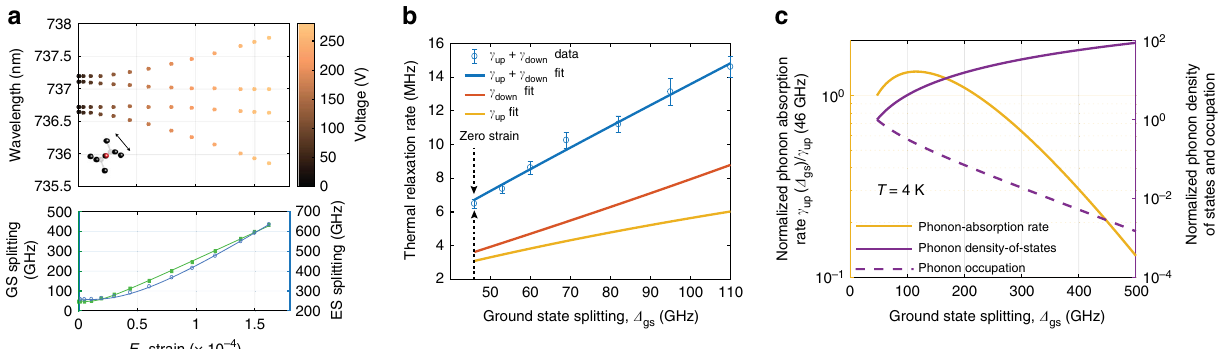
Fig. 2 Strain-tuning of the SiV − energy levels. a Strain response of a transverse-orientation SiV − as shown in Fig. 1c. Wavelengths of the four optical transitions A, B, C, and D are recorded against strain. Raw PLE data with applied voltages can be found in Supplementary Fig. 7. The lower panel shows orbital splittings within GS (solid green squares) and ES (open blue circles) extracted from the optical transition wavelengths. Solid curves are fi ts to group theory-based strain response model. 27, 29 b Thermal relaxation rates between GS orbital branches vs. their energy splitting. Error bars represent standard deviation of the estimated rate, and are under 5% for all data points. Fit to model in Supplementary Discussion allows extraction of the phonon-absorption rate γ up and phonon-emission rate γ down . c Calculated phonon-absorption rate γ up ( Δ gs ) (solid yellow line) as a function of GS-orbital splitting Δ gs at temperature T = 4 K. Left y -axis indicates the magnitude of this rate normalized to the value at zero strain, γ up (46 GHz). Right y -axis indicates the two competing factors whose product determines γ up : the phonon density of states (normalized to its value at zero strain), shown with the solid violet line, and the thermal occupation of acoustic modes shown with the dashed violet line